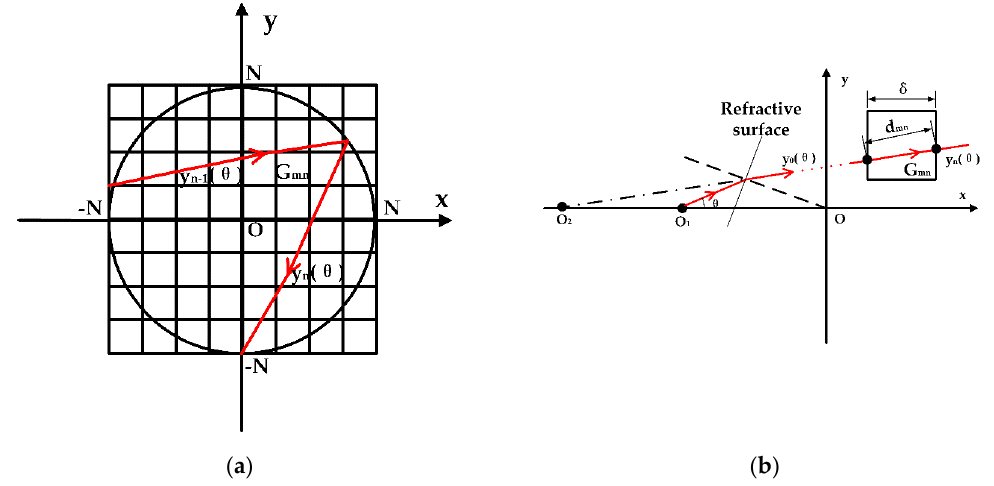
Figure 4. ( a ) Gridding profile of laser rod; ( b ) absorbed power of a grid from any ray of y n ( θ )